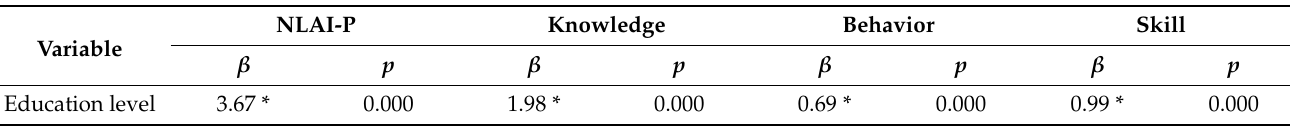
Table 10. The correlation coefficients between education level and the NLAI-P scores of Chinese pregnant